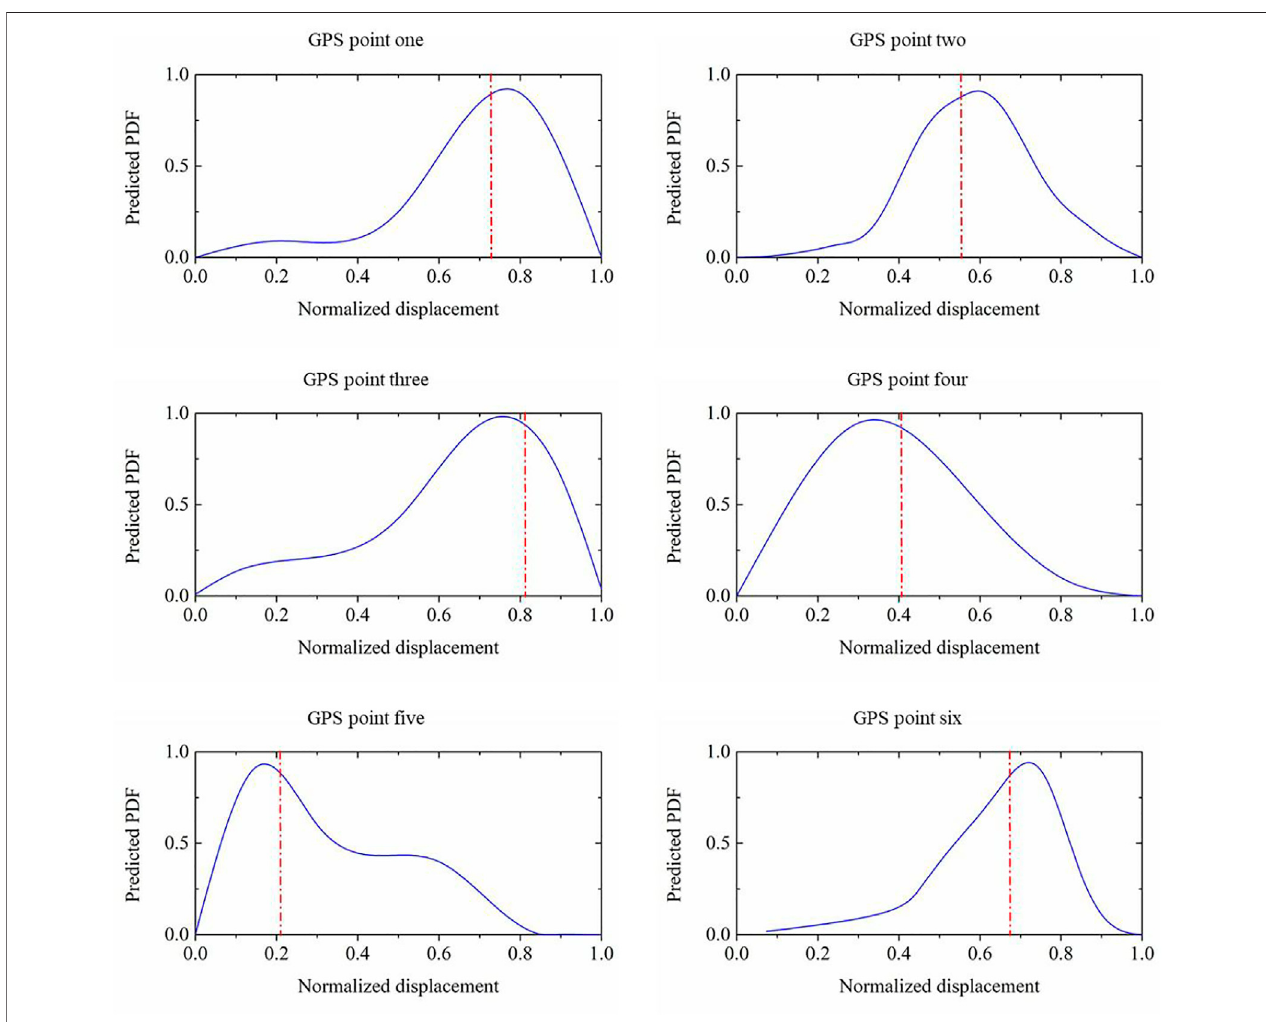
FIGURE 4 | Constructed PIs and actual target instant displacement of the test